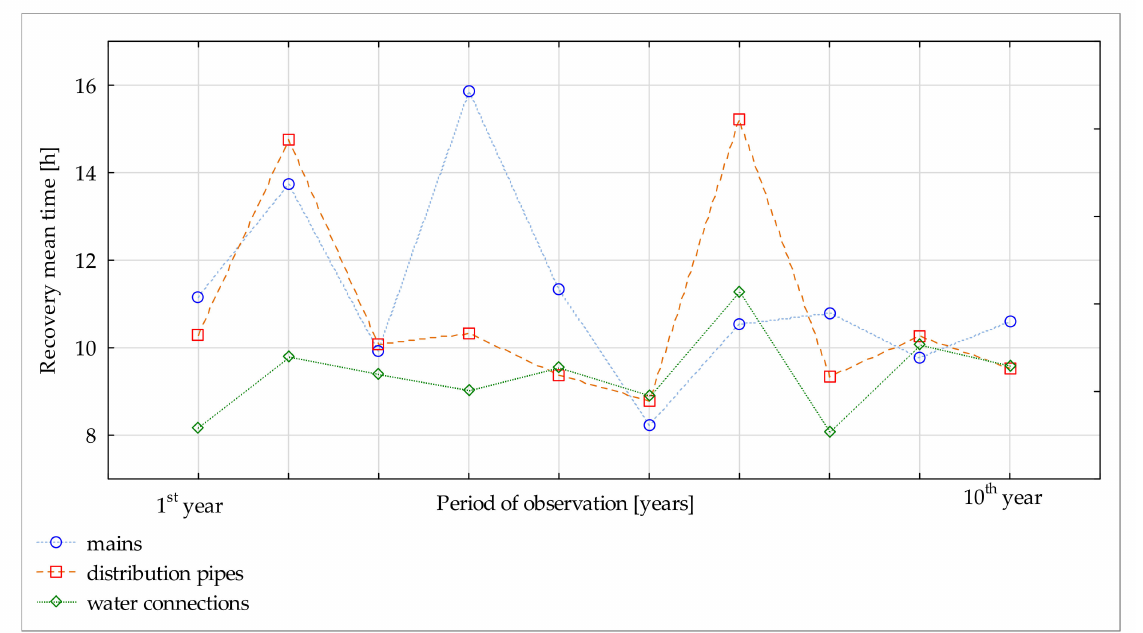
Figure 6. The recovery meantime in each year of the